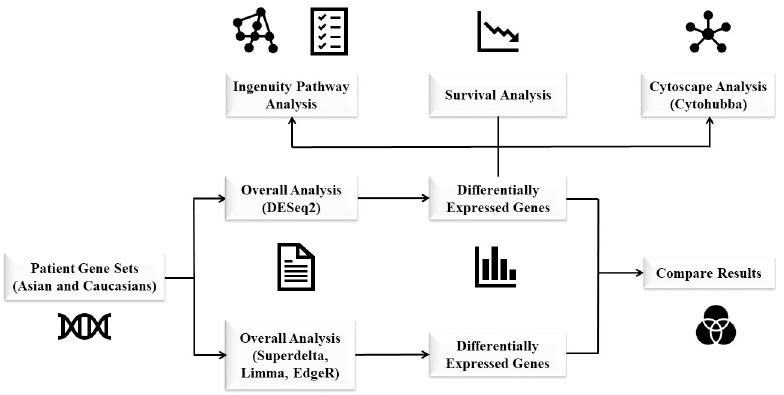
Fig 1. Work flowchart used for data